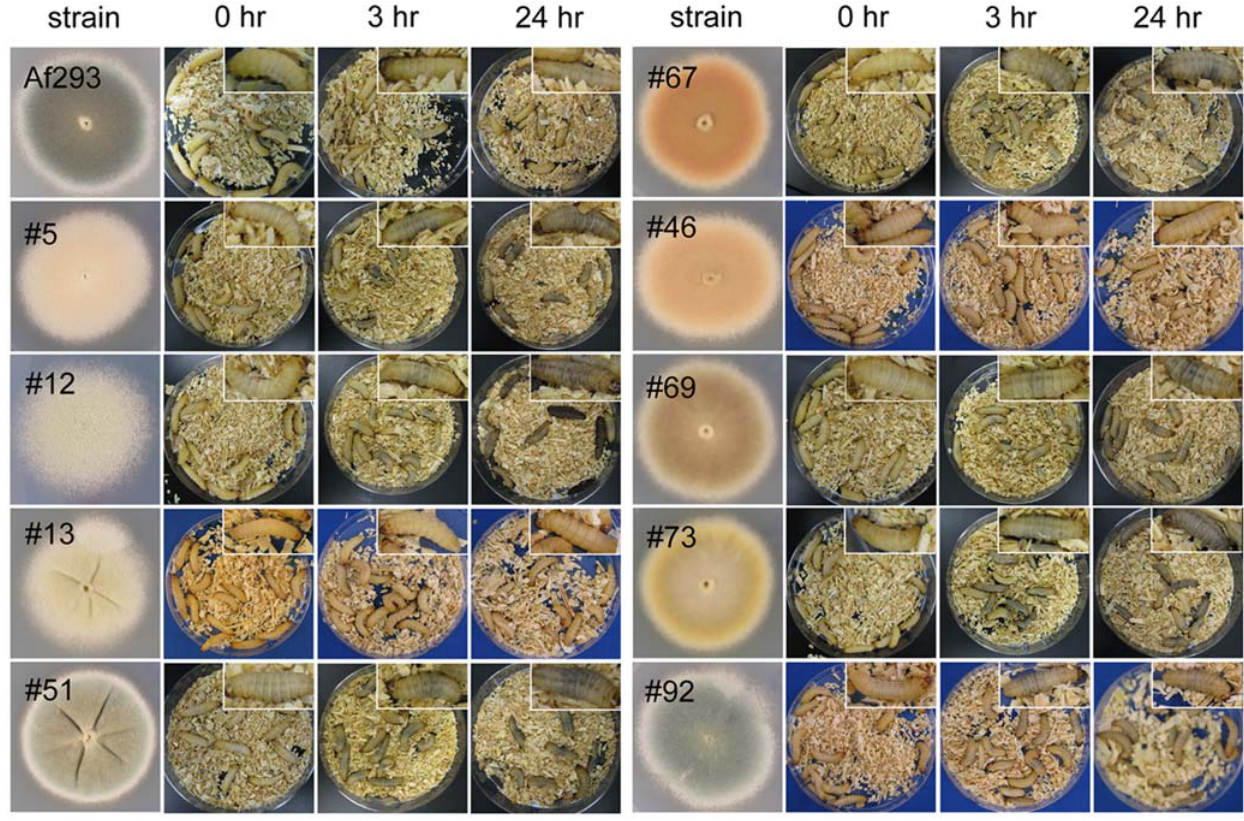
Figure 8. Infection with A.fumigatus color mutants in the Af293 background causes G.mellonella larvae to darken shortly after inoculation. Larvae were infected and A. fumigatus Af293 wild type strain and selected color mutants # 5, # 12, # 13, # 51, # 67, # 46, # 69, # 73, and # 92 at the concentration of 1 6 10 6 conidia per caterpillar. From left to right are images of A. fumigatus colonies, G. mellonella larvae at T=0 h, 3 h, and 24 h post infection. Insets are close-up images of a representative single caterpillar from the same plate.